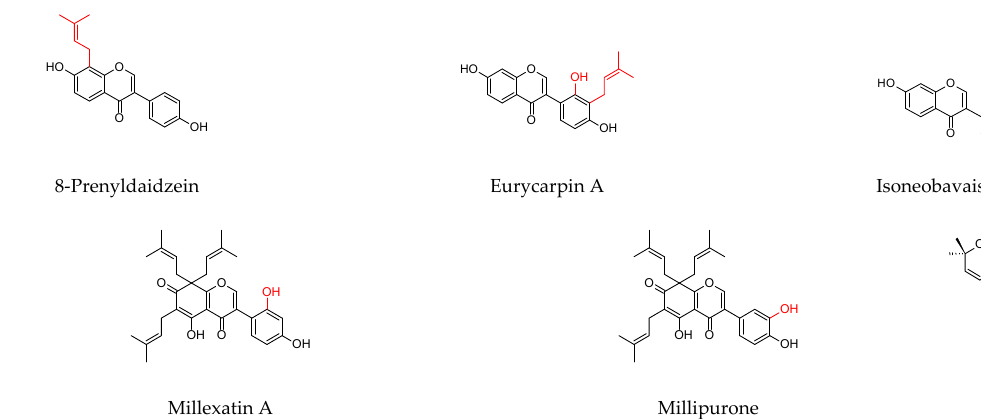
Figure 9. Structures of discussed isoflavones.